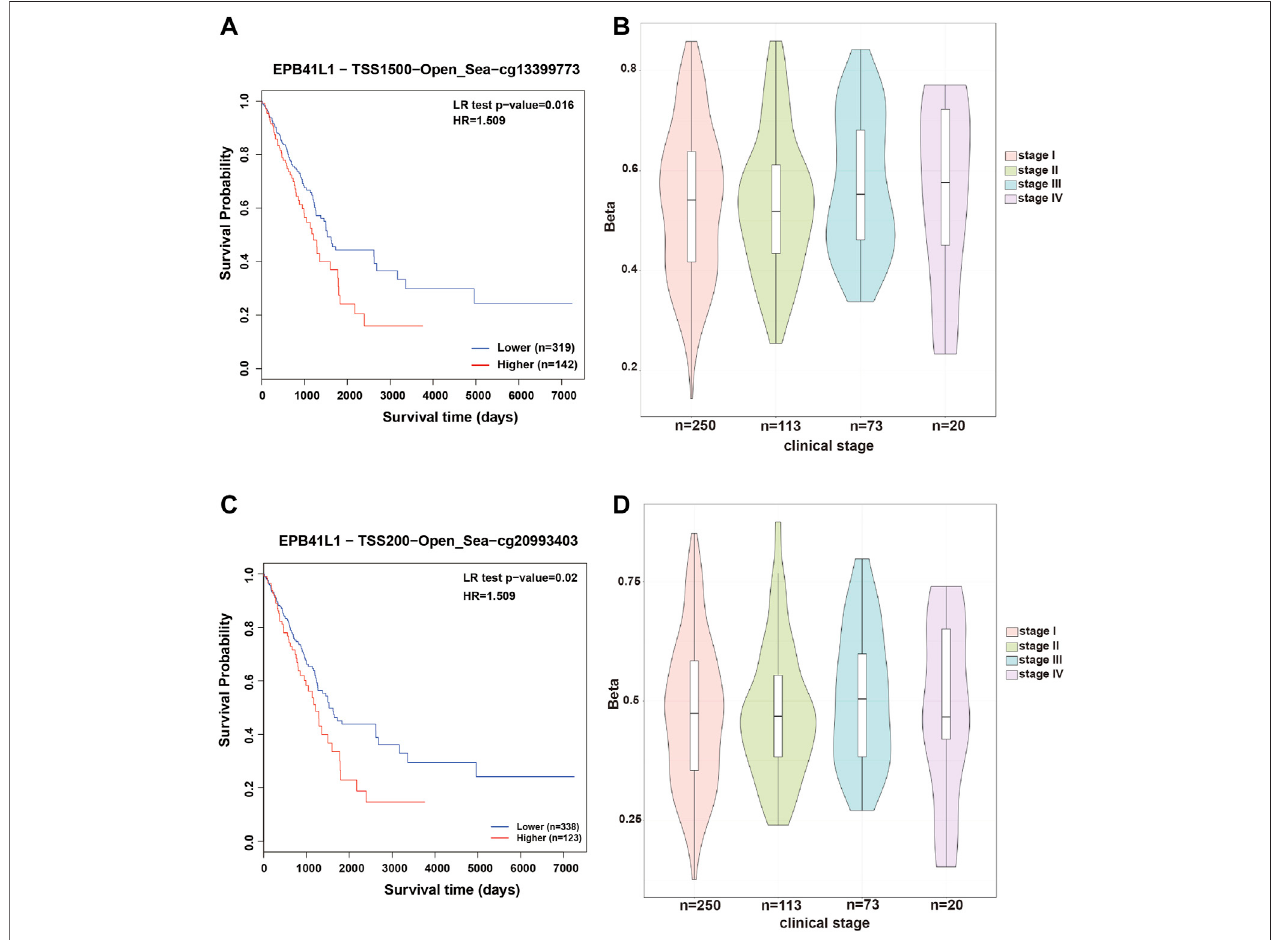
FIGURE 3 | Methylation levels and prognosis of the 4.1N/ EPB41L1 promoter in patients with LUAD. (A) Kaplan – Meier curves for cg13399773-4.1N showing survivalinlower(beta < 0.611,showninblue)andhighermethylationgroups(beta > 0.611,showninred)dichotomizedbythemaxstatmethod. (C) Kaplan – Meiercurves for cg20993403-4.1N showing survival in lower (beta < 0.59, shown in blue) and higher methylation groups (beta > 0.59, shown in red) dichotomized by the maxstat method. (B,D) Violinplotsshowingthemethylationlevelsofcg13399773-4.1Nandcg20993403-4.1NamongstageI – IVLUADpatients.Medianmethylationlevels (show by a thick black line) and interquartile range were summarized by the boxplot within each violin plot. HR: hazard ratio; LR: log-likelihood ratio; LUAD: lung adenocarcinoma. Methylation levels were represented as beta values. Any beta value equal to or greater than 0.6 wasconsidered fully methylated. Anybeta value equal to or less than 0.2 was considered to be fully unmethylated. Beta values between 0.2 and 0.6 were considered to be partially